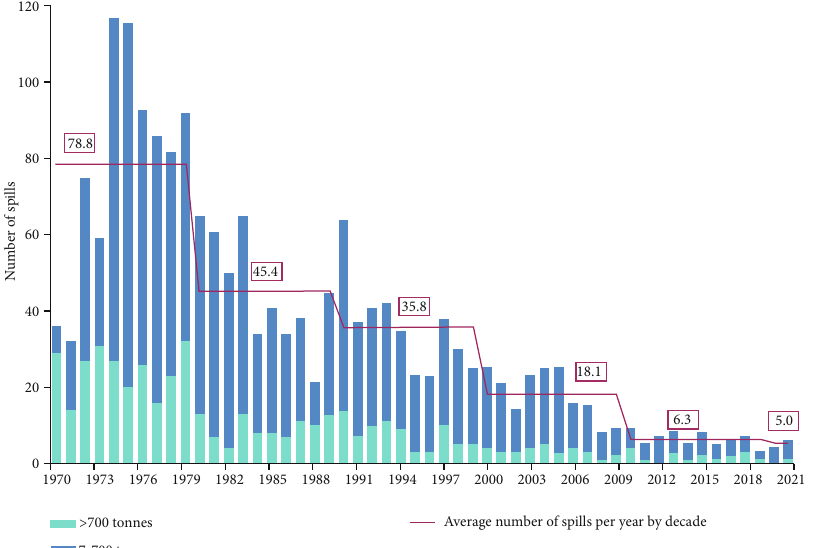
Figure 11: Number of oil spills from tankers worldwide, 1970-2021 (ITOPF,